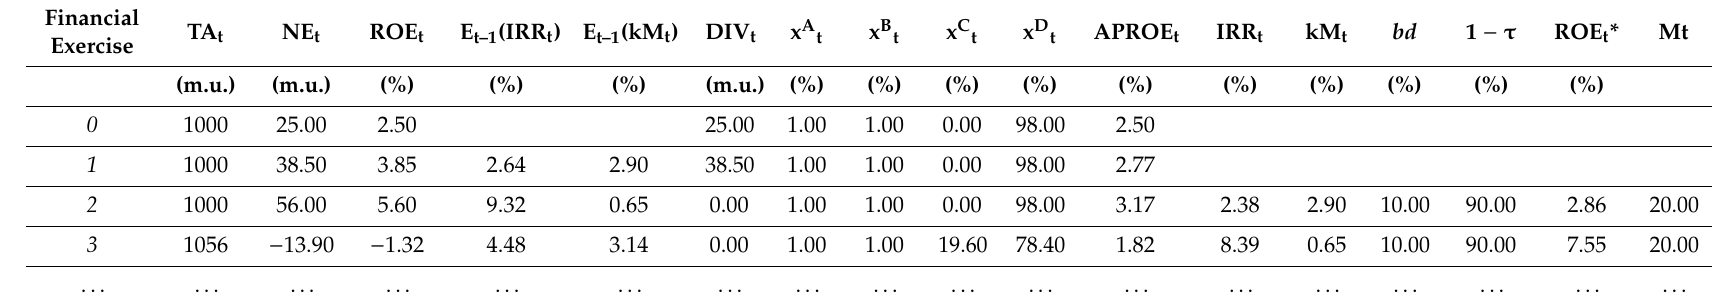
Table 4. Numerical simulation for the financial indicators